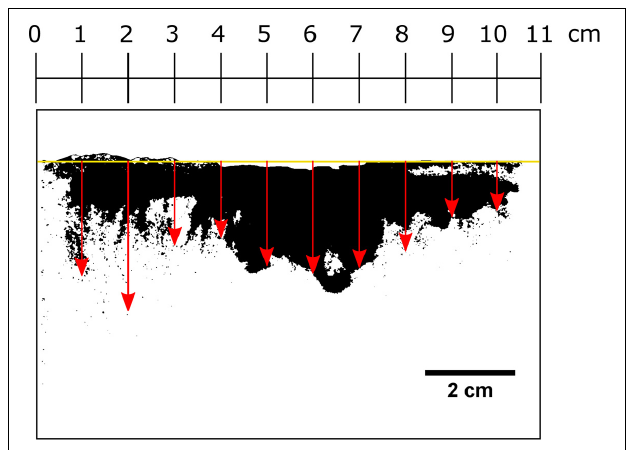
FIGURE 5 | Procedure for determining the smearing extent directly at the inserted plate. The average height of the sediment surface was determined (yellow line) and the width of the visible sediment column was divided into vertical 1-cm intervals. The depth in which luminophores were present at each centimetre was recorded indicated here by red arrows.